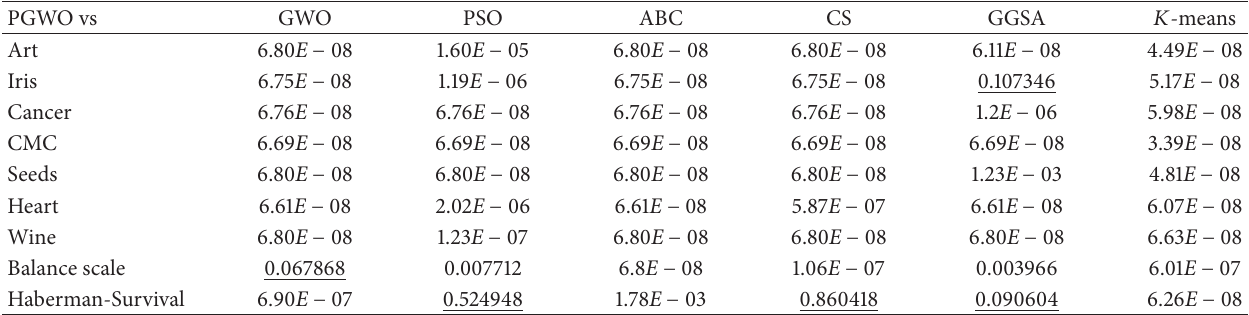
Table 6: 𝑝 values produced by Wilcoxon’s rank-sum test comparing PGWO versus GWO, PSO, ABC, CS, GGSA, and 𝐾 -means over data sets ( 𝑝 ≥ 0.05 have been